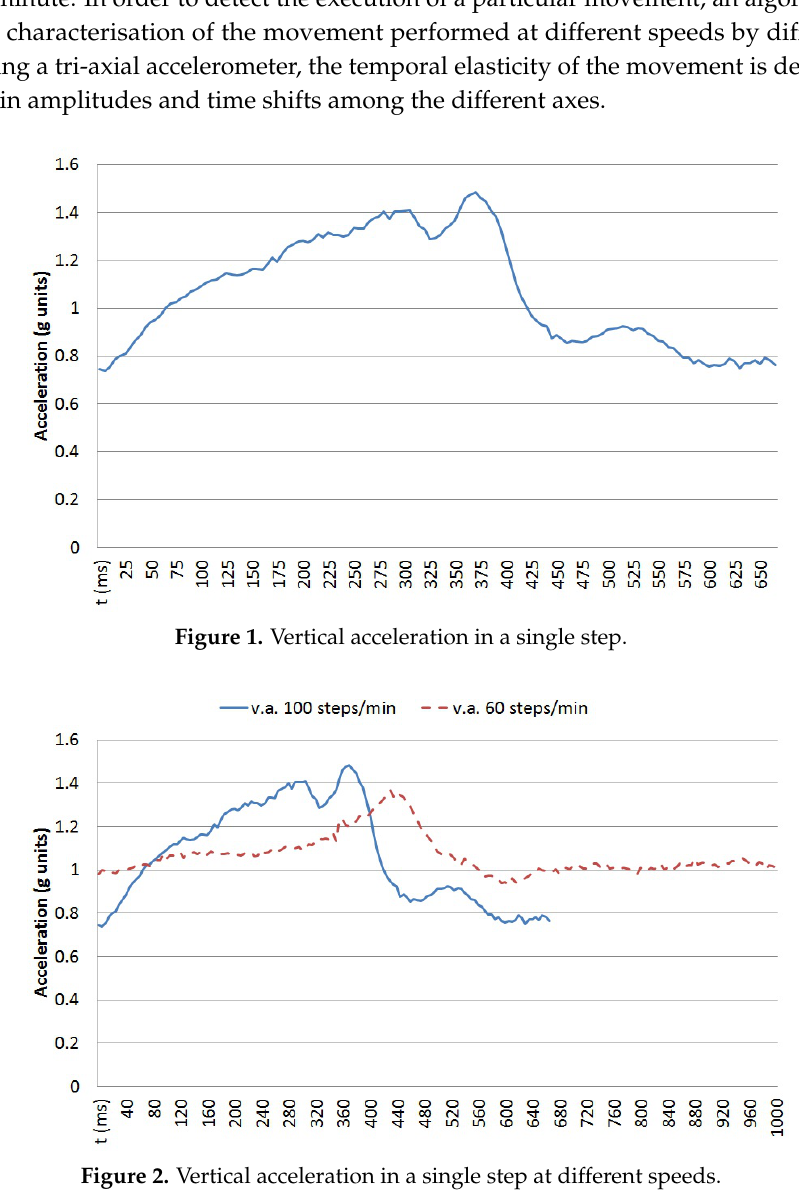
Figure 2. Vertical acceleration in a single step at different